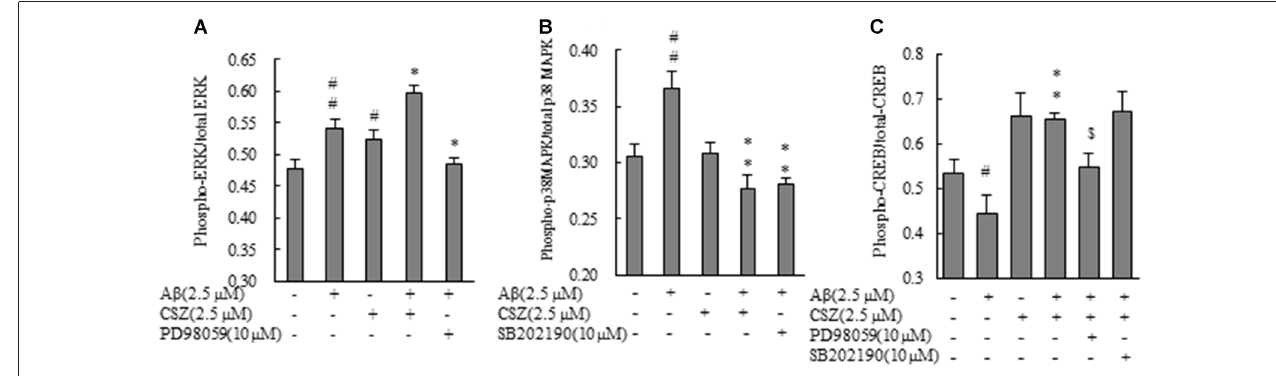
FIGURE 5 | Effects of CSZ on phosphorylation of extracellular signal-regulated kinase1/2 (ERK1/2), p38 MAPK and cyclic adenosine monophosphate response element-binding protein (CREB) in A β -stimulated SH-SY5Y cells. Phosphorylation of ERK1/2, p38 MAPK and CREB were examined using ELISA kit described in “Materials and Methods” section. (A) ERK1/2 phosphorylation. (B) p38 MAPK phosphorylation. SH-SY5Y cells were incubated with or without pretreatment with CSZ for 1 h followed by treatment with A β for 30 min. The effects of respective inhibitor were also examined. (C) CREB phosphorylation. Values are expressed as mean + SEM # Compared vs. respective control cells ( p < 0.05). ## Compared vs. respective control cells ( p < 0.01). ∗ Compared vs. A β -treated cells ( p < 0.05). ∗∗ Compared vs. A β -treated cells ( p < 0.01). $ Compared vs. A β + CSZ-treated cells ( p < 0.01).